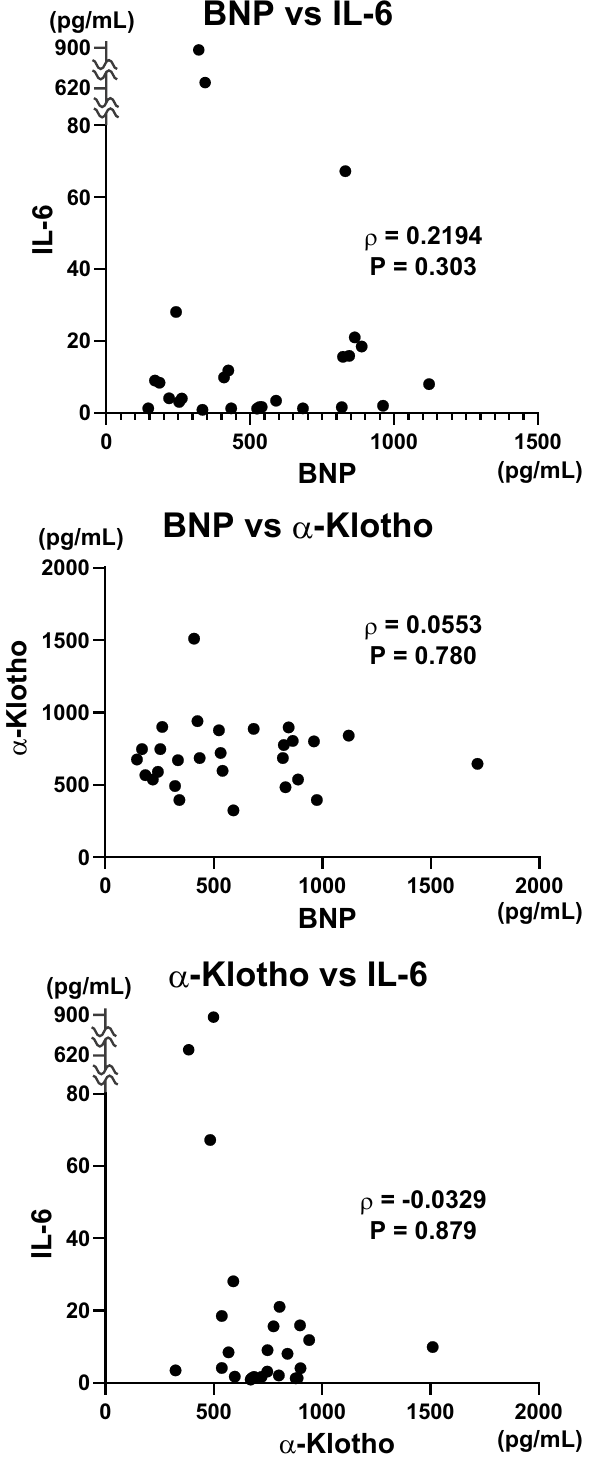
Figure 1. Correlation between serum BNP, IL-6, and α-Klotho levels. Serum BNP, IL-6, and α-Klotho levels were measured on admission. Spearman’s correlation coefficient was used. BNP, brain natriuretic peptide; IL-6,